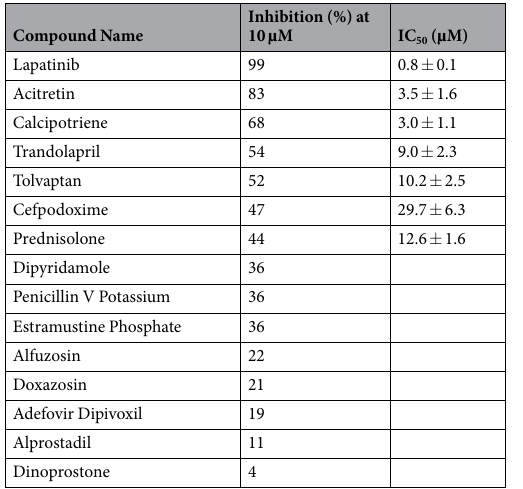
Table 1. The FDA-approved drugs selected from virtual screening and tested for their in vitro inhibitory activity against human